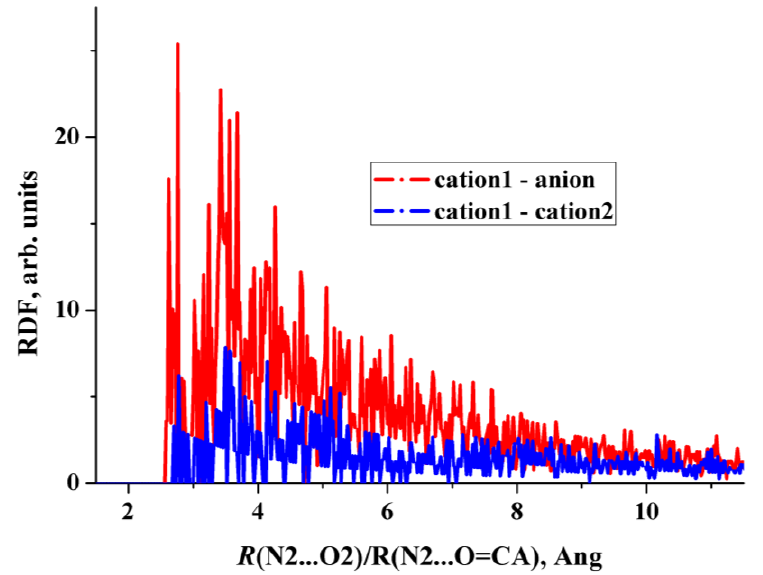
Figure 7. The radial distribution function of the R[N2 ··· O2] (red) and R[N2 ··· O=CA] (blue) distances obtained from the 100 ns NPT simulations.